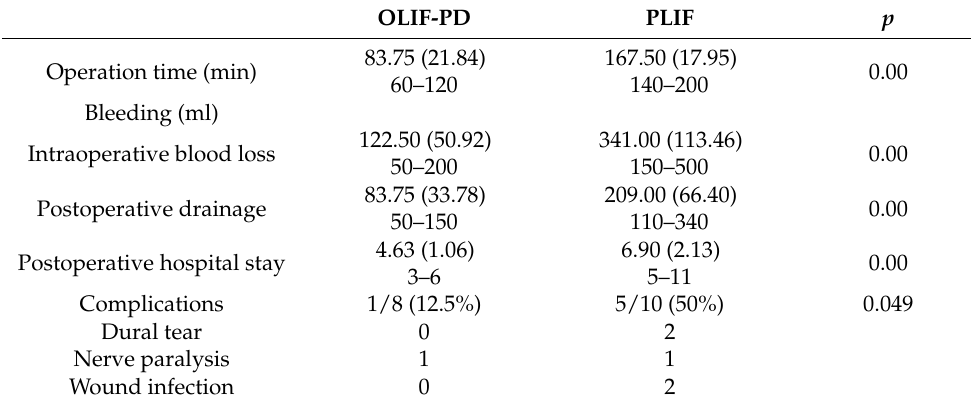
Table 2. Comparison of surgery-related data between the two